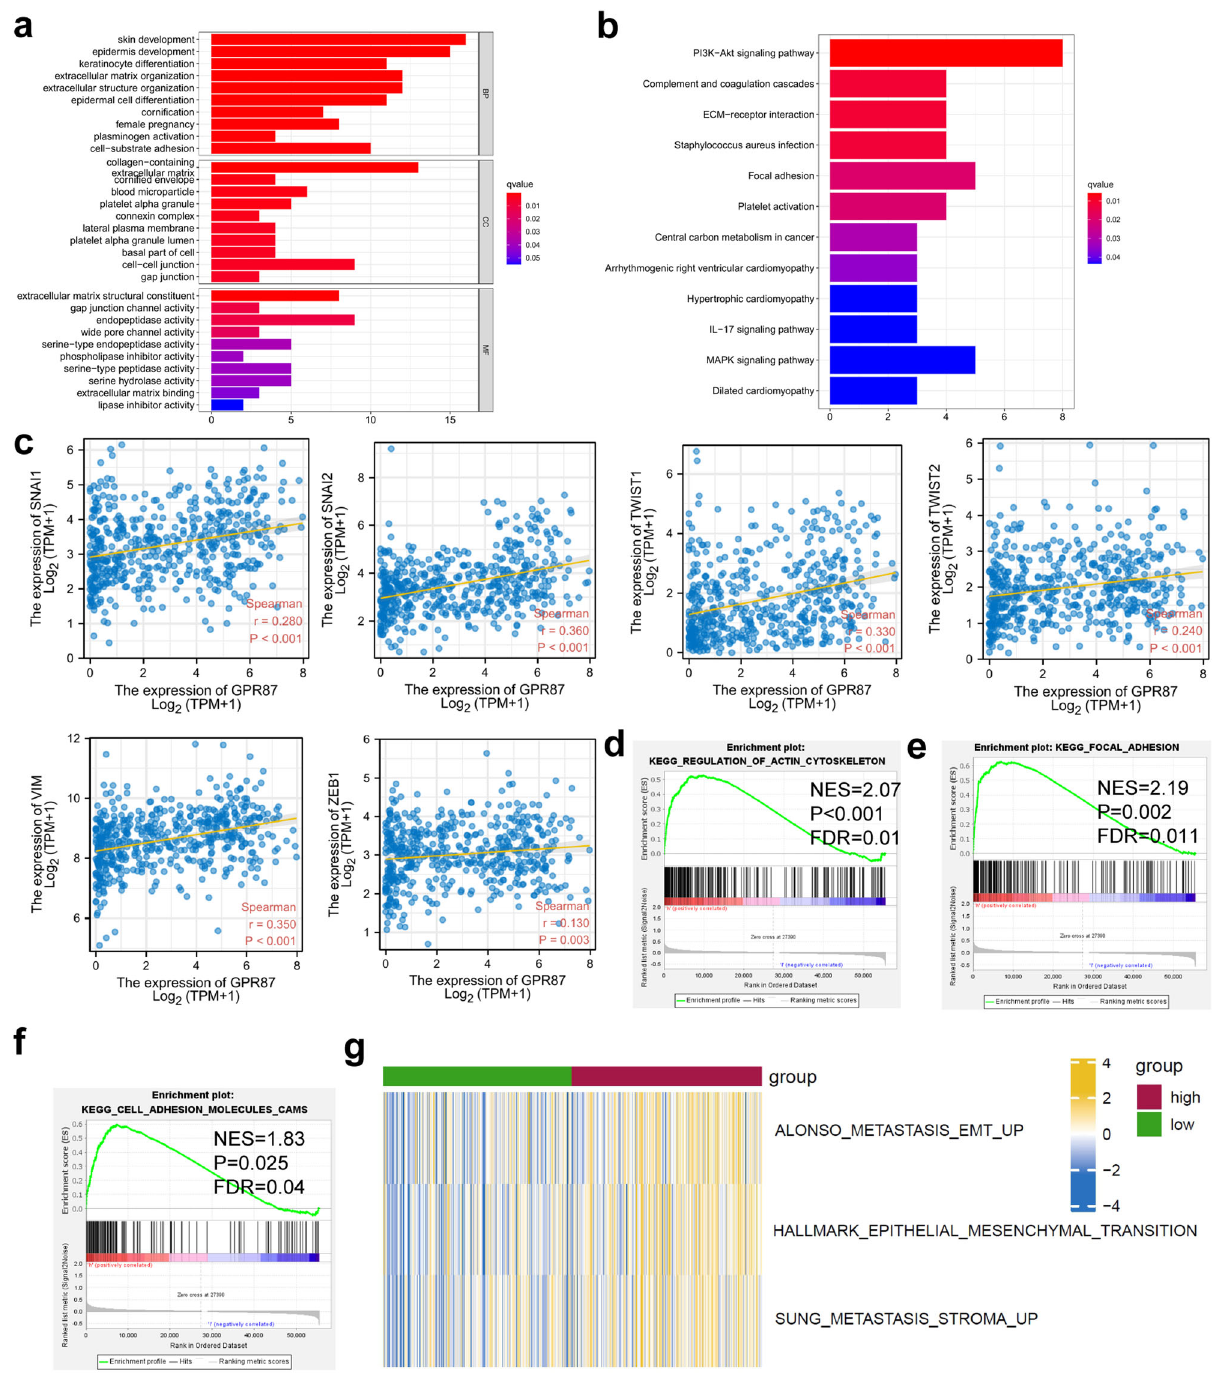
Fig. 2 Functional enrichment analysis to verify the association of GPR87 with EMT. a GO enrichment analysis. b KEGG enrichment analysis. c GPR87 is positively correlated with EMT-related gene transcription. Regulation of actin cytoskeleton ( d ), focal adhesion ( e ), and CAMs ( f ). g RNA-seq data from LUAD patients in the TCGA database were analyzed using the ssGSEA algorithm to evaluate the association of GPR87 with tumor